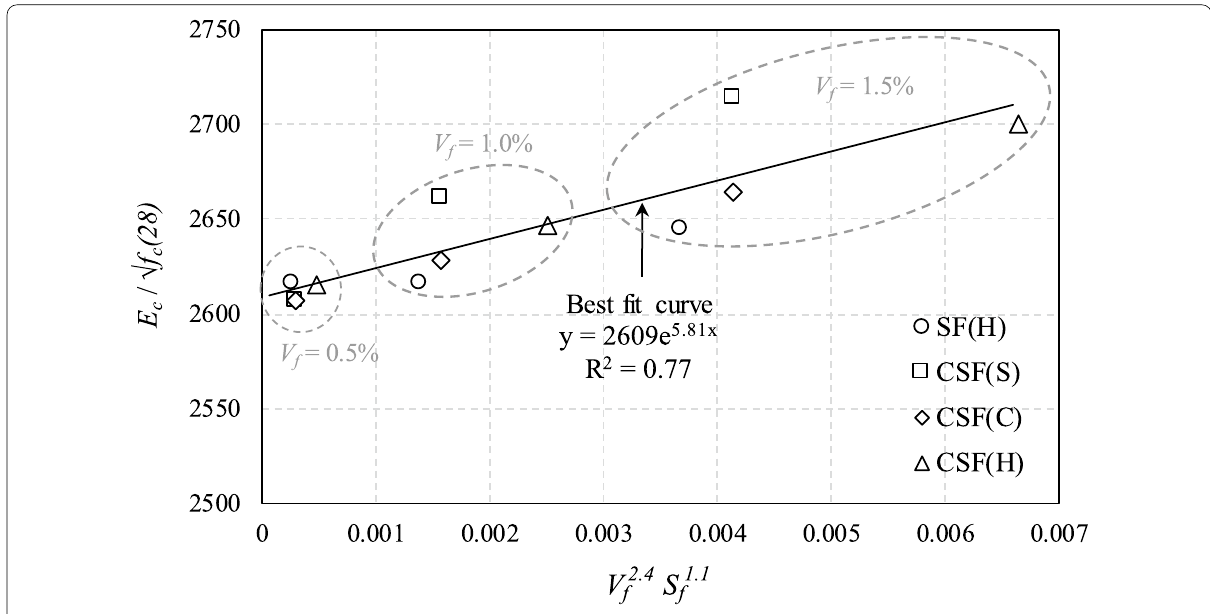
Fig. 13 Regression analysis for normalized elasticity modulus of